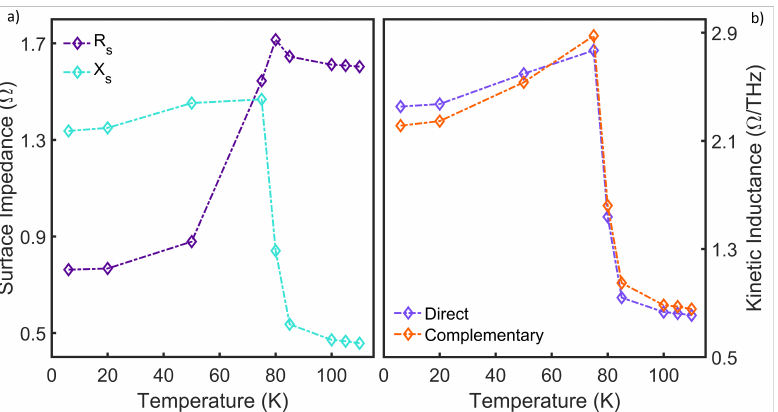
Figure 5. ( a ) Surface resistance ( R s ) and reactance ( X s ) associated with the unpatterned YBCO film as a function of temperature. The complex quantity was calculated by using experimental complex conductivity of the unpatterned YBCO film at a fixed frequency ν = 0.8 THz, around the LC resonance frequency of the metamaterial. ( b ) Kinetic inductance calculated at the LC resonance frequency, whose values are depicted in Figures 3a and 4a, as a function of temperature for both direct and complementary